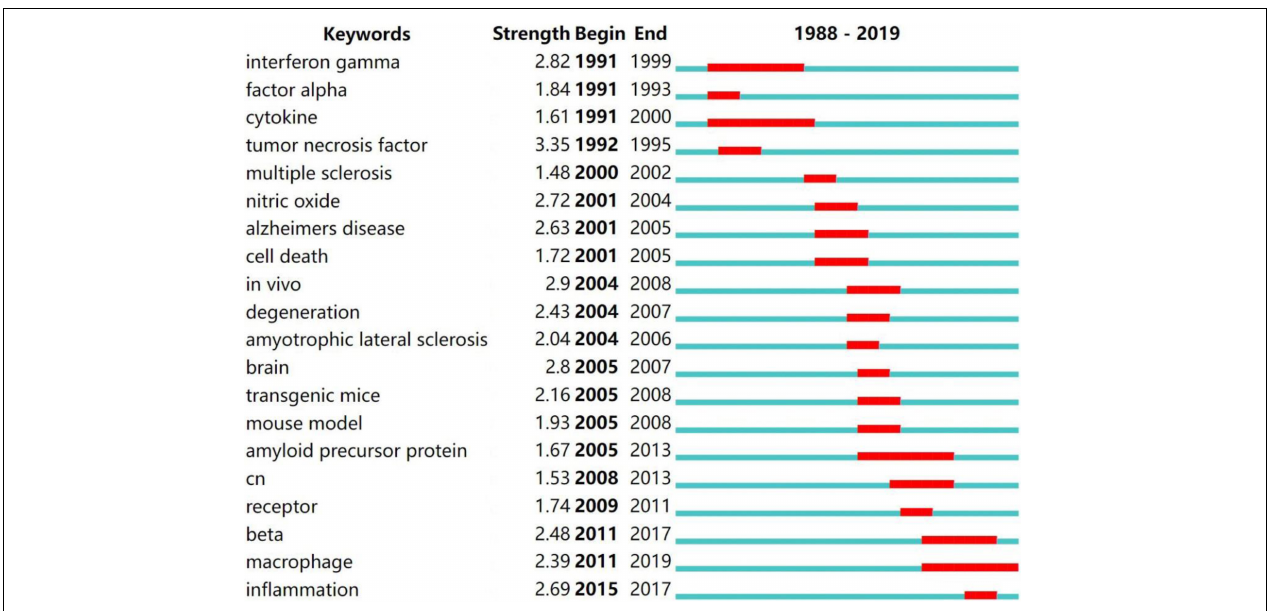
FIGURE 13 | Burst detection of author